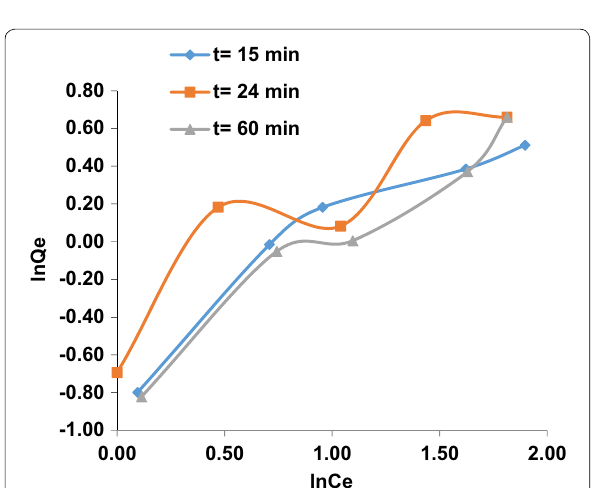
Fig. 10 Adsorption isotherms of arsenic (III) ion on the composite HAp/GA at t 15 min, t 24 min and t 60 min, linearized accord- = = = ing to Freundlich